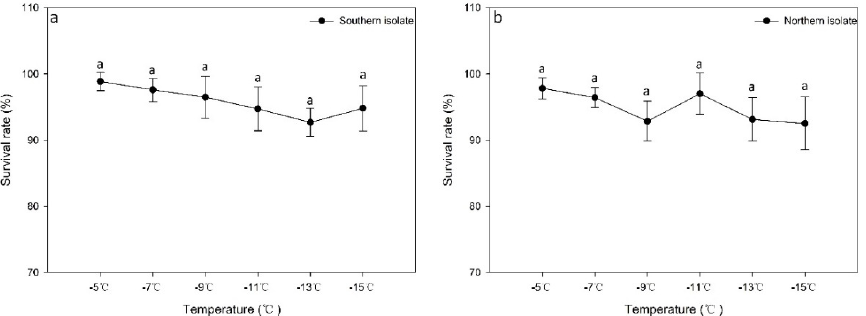
Figure 2. Effect of temperature on the survival of two mixed − stage pine wood nematode isolates after cooling to various T min at 0.5 °C min − 1 . Southern isolate is the YD isolate from the subtropical zone ( a ); Northern isolate is the XB isolate from the mid-temperate zone ( b ). Standard errors are represented by error bars, the letter (a) above bars denotes significant differences at p < 0.05.